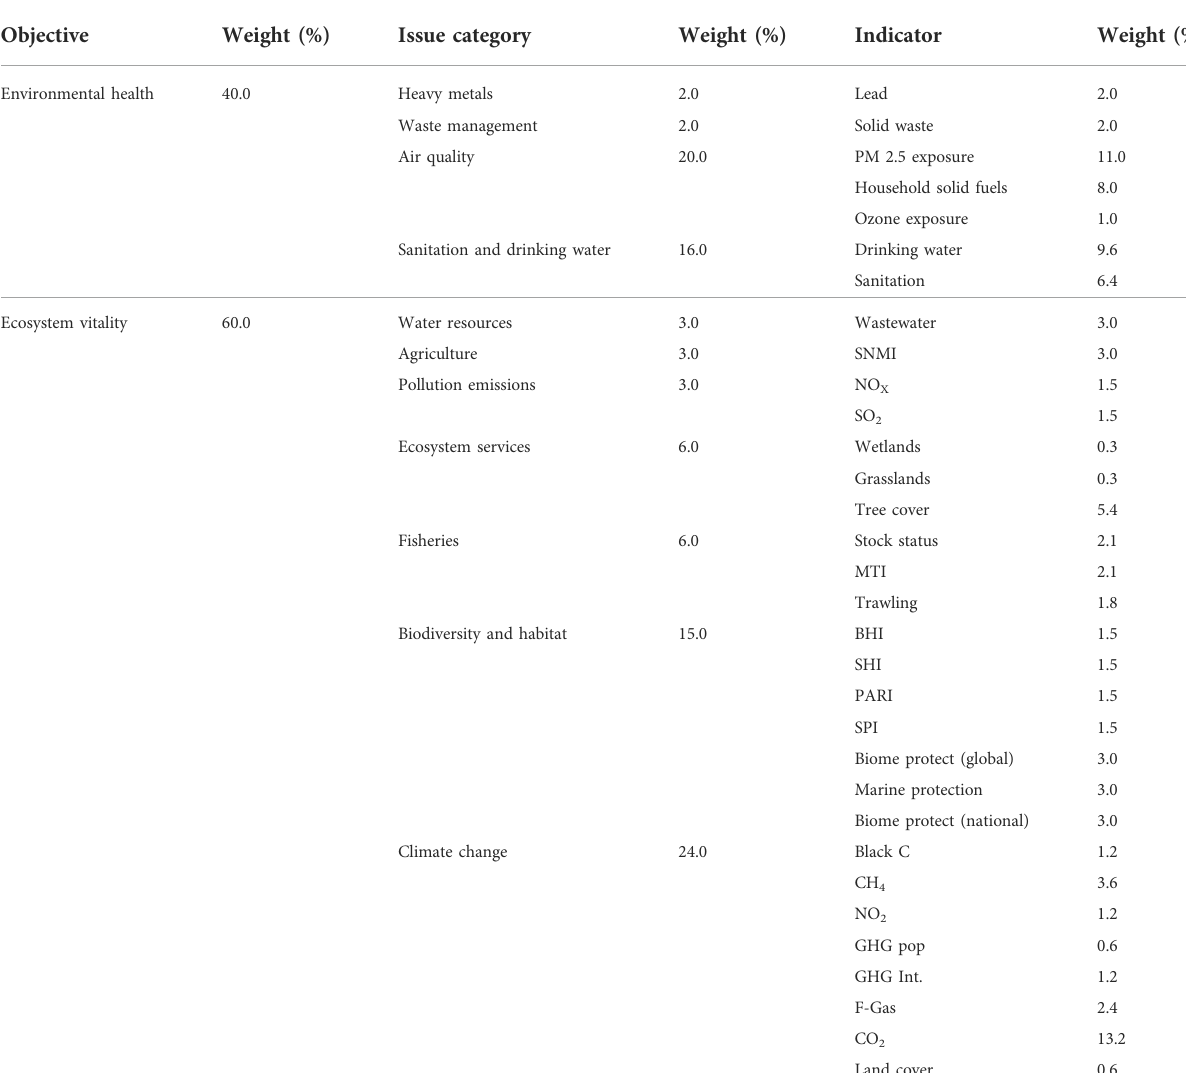
TABLE 1 Composition and weight decomposition of the